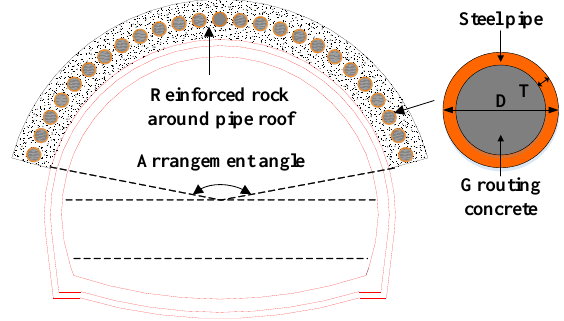
Figure 10. Arrangement sketch of pipe roof pre-support (PRPS).